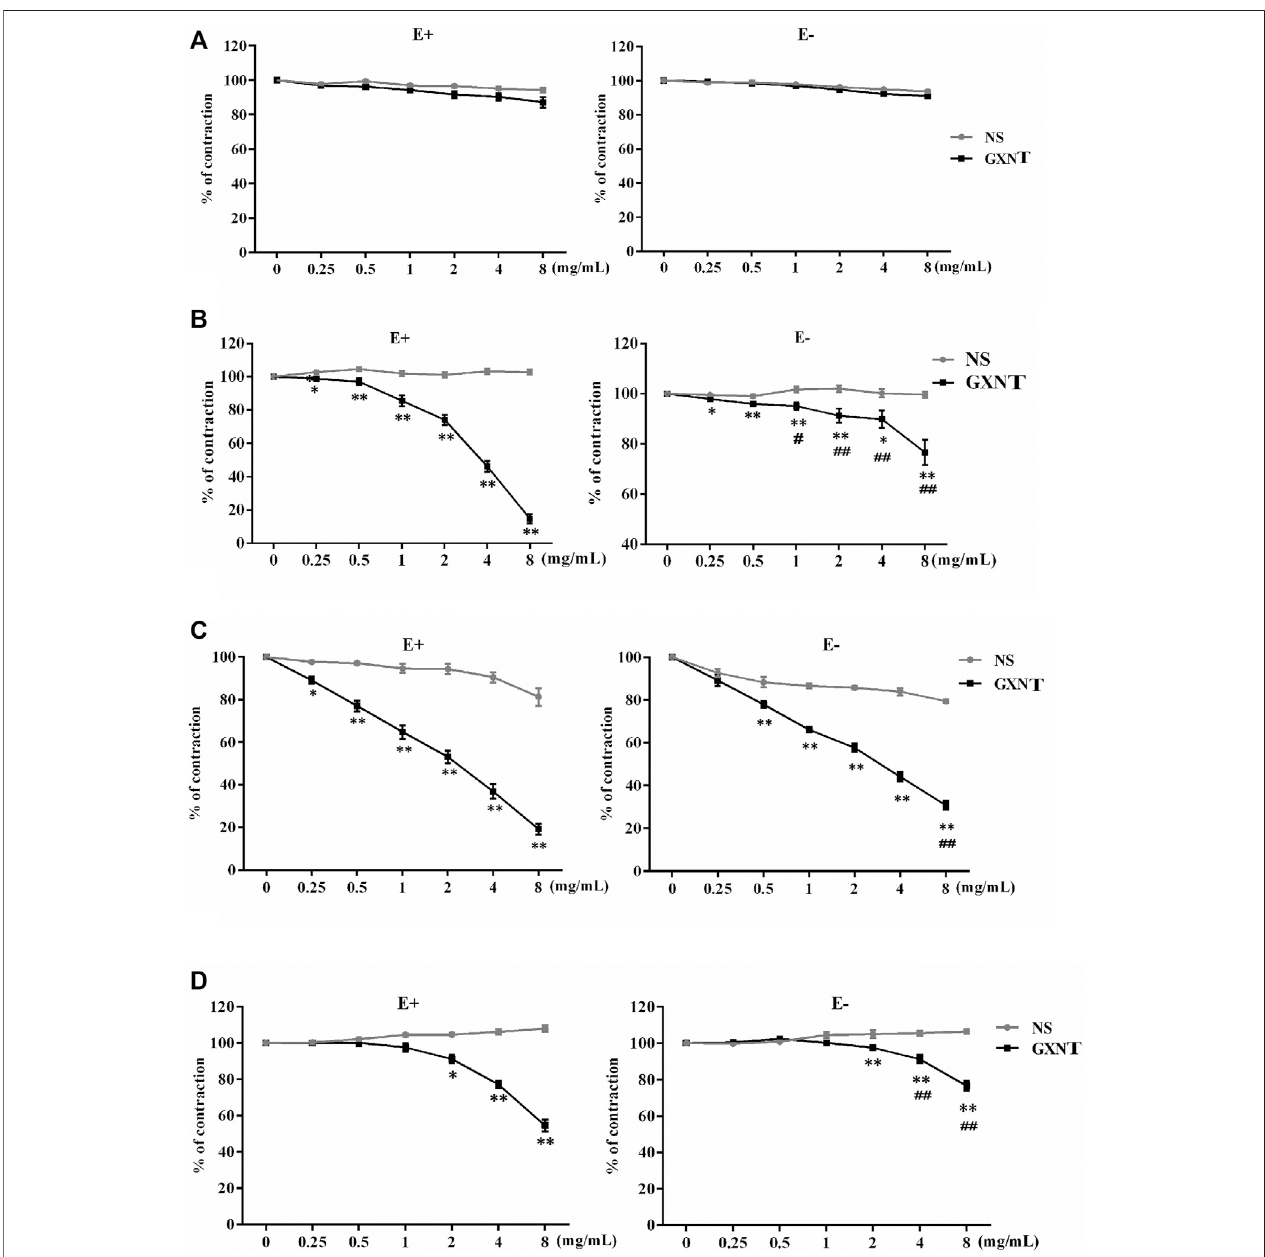
FIGURE 1 | Effects of Guanxinning tablet (GXNT) on the contraction of isolated thoracic aortic rings induced by phenylephrine (PE), norepinephrine (NE), and KCl. AfterequilibrationinKrebs – Henseleit(K – H)solution,vascularringswithorwithoutendotheliumwerepretreatedwithnormalsaline (A) ,10 − 6 mol/LPE (B) ,10 − 6 mol/LNE (C) , or 60 mmol/L KCl (D) for 20 min. Then, GXNT was added to the solution to 0.25, 0.5, 1, 2, 4, and 8 mg/ml. The concentration of GXNT was increased every 8 min, and changes in tension were recorded after stabilization. The vasoconstrictive tension before addition of the drug was taken as 100% of the normal control group, and the tension after addition of the drug action was compared with it and is reported as a percentage. ( *p < 0.05, ** p < 0.01 compared with the NS group, ## p < 0.01 comparedwithvascularringswithintactendothelium).Resultsarepresentedasthemean ± SDofthedataobtainedinthreeindependentexperimentswithsixduplicate